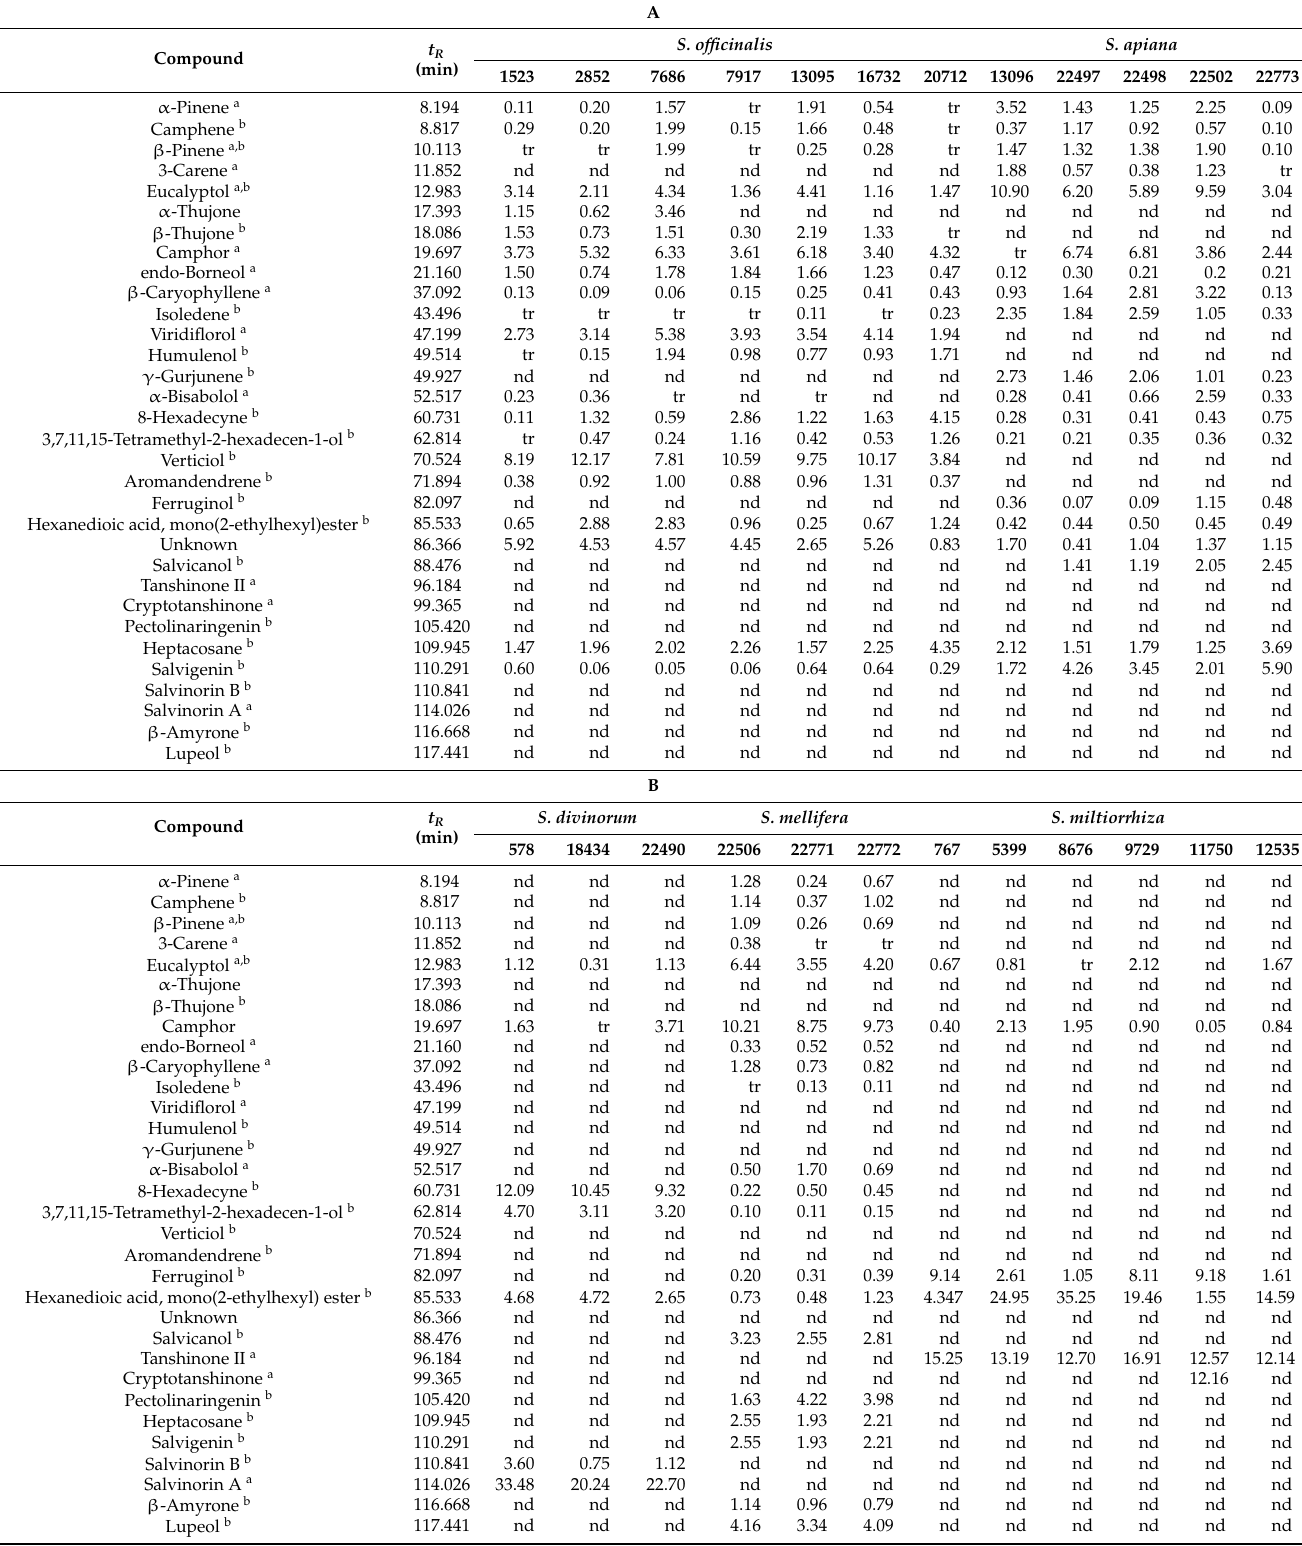
Table 2. Tentative compound identification based on NIST library and percent (% peak area) of volatile compounds in methylene chloride extracts of (A) S. officinalis and S. apiana